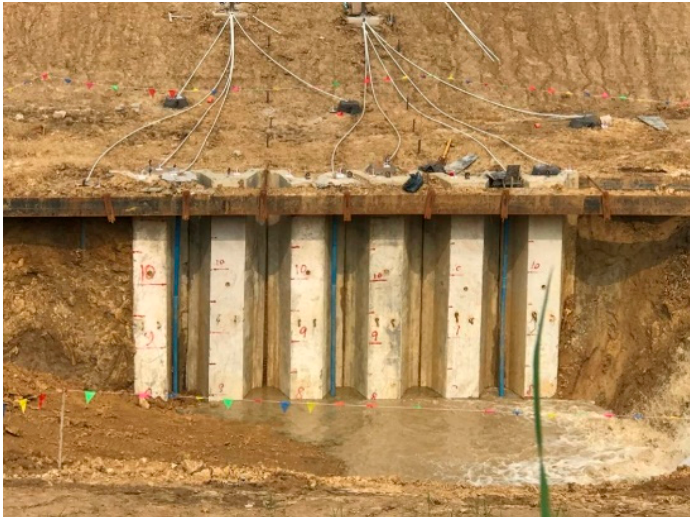
Figure 3. U-shaped sheet-pile engineering field profile.